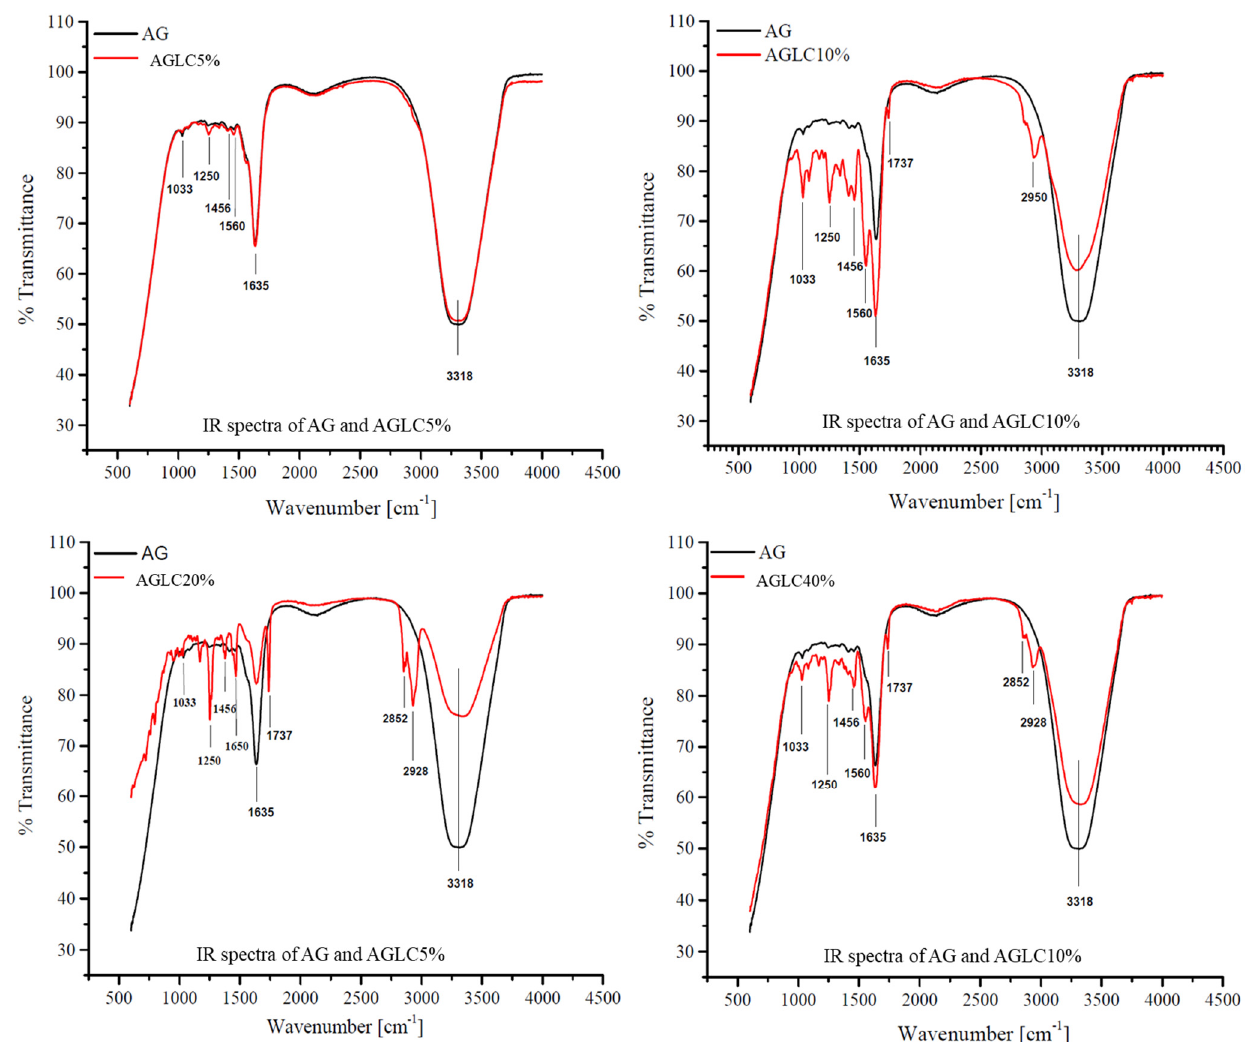
Figure A2. IR spectra of the